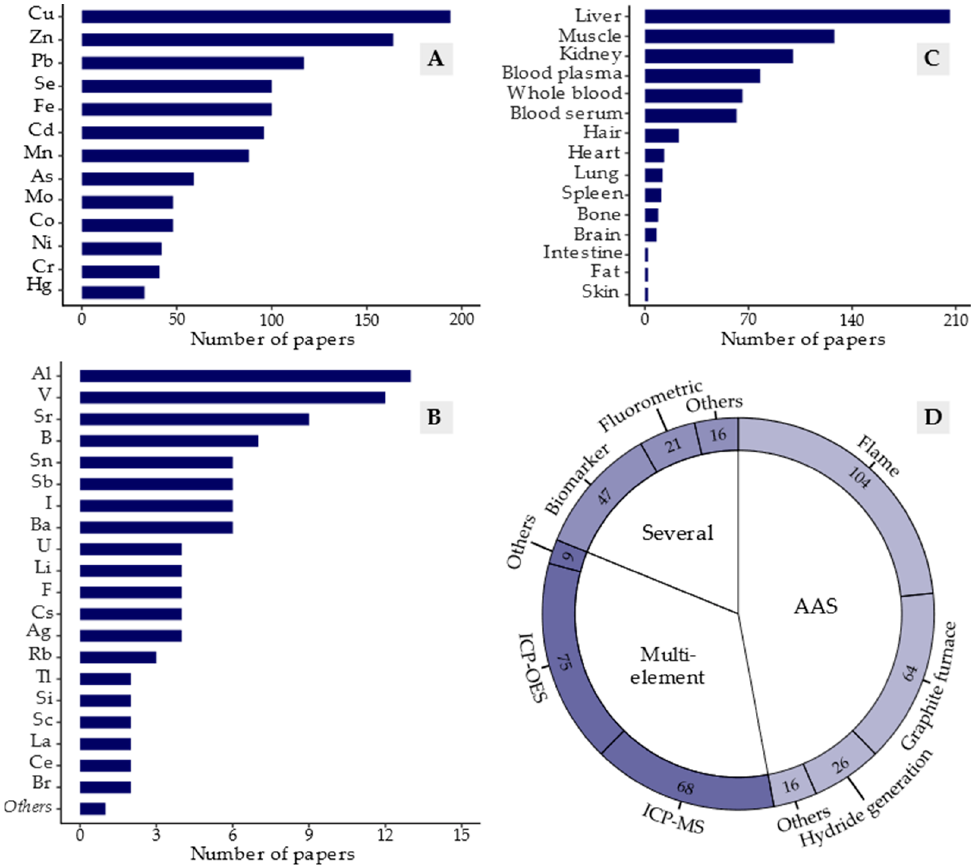
Figure 3. Number of papers published in the period 2000–2022 about trace elements in beef cattle production: ( A ) trace elements most studied; ( B ) trace elements less studied; Others elements: Ar, Au, Be, Bi, Dy, Er, Eu, Ga, Gd, Hf, Ho, In, Ir, Lu, Nd, Pr, Pt, Sm, Te, Ti, Th, Tm, Yb; ( C ) bovine tissues analysed; ( D ) main analytical techniques used.